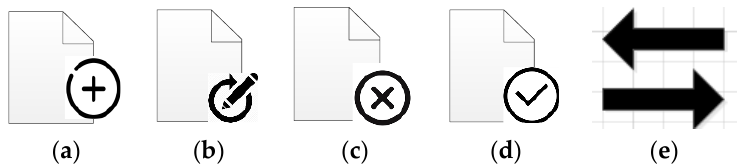
Figure 5. Different states of the document object using a BPMN extension. ( a ) create, ( b ) update, ( c ) delete, ( d ) approve, ( e ) transfer.